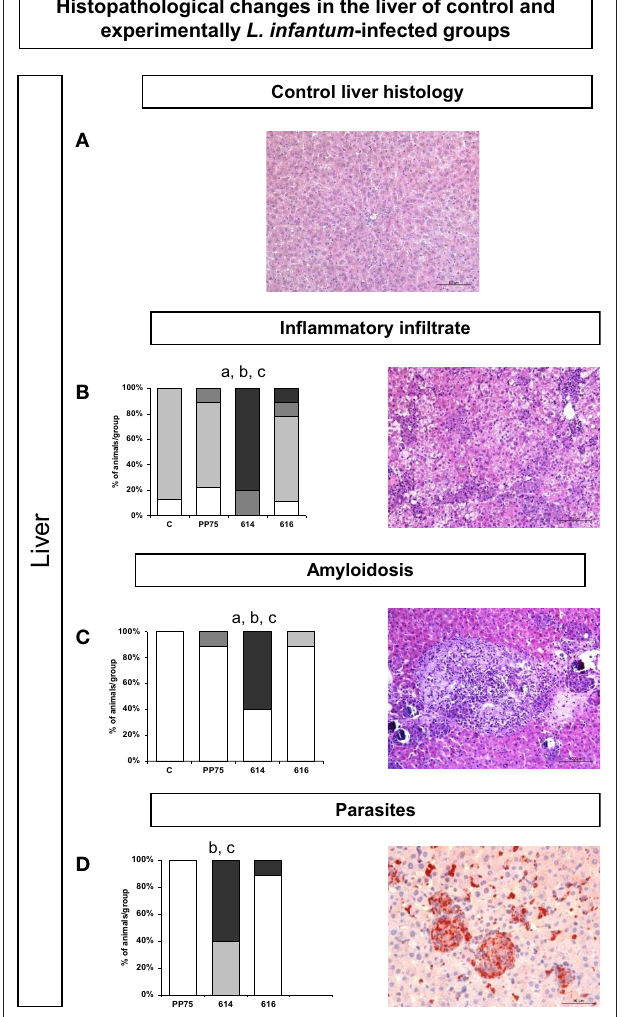
FIGURE 4 | Frequency and histopathological changes in the liver of control group and experimentally L. infantum -infected groups (reference strain: PP75; and wild strains: 614 and 616). The intensity of histopathological changes was graded as absent ( − , ), mild ( + , ), moderate ( ++ , ), and severe ( + + + , ). The histopathology analysis was performed for inflammatory infiltrate (B) , amyloidosis (C) , and parasitism (D) . Images obtained from optical microscopy illustrate each analysis of HE-stained (A–C) and immunohistochemistry (D) slides for all evaluated histopathological parameters. Representative images (B–D) correspond to animal samples from the group most affected by the infection (614). An image of the control liver histology (A) was included to illustrate the normal histological condition in hamsters. Statistically significant differences are highlighted by the letters “a,” “b,” and “c” as compared to Control (C) , PP75, and 616, respectively, at P < 0.05. hemoglobin, and hematocrit, as compared to the other experimental groups (C, PP75, and 616) ( Table 2 ). Moreover, infection with the 614 strain produced lower ( P < 0.05)